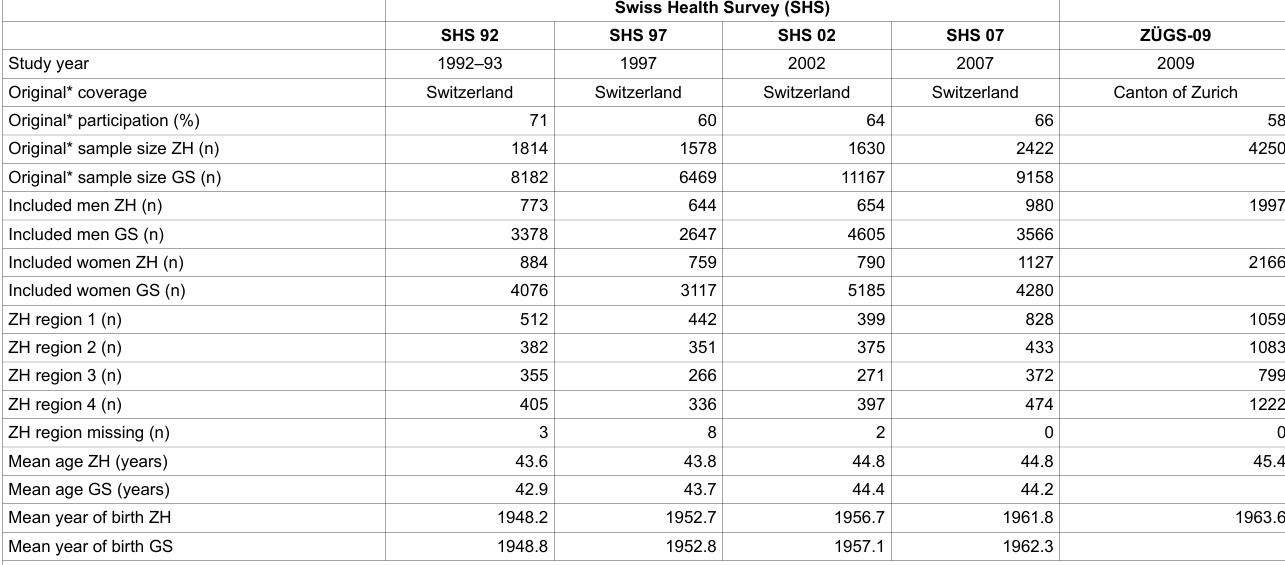
Table 1 Counts and population weighted means and medians by survey, 1992–2009, men and women aged 18–74 years (n =